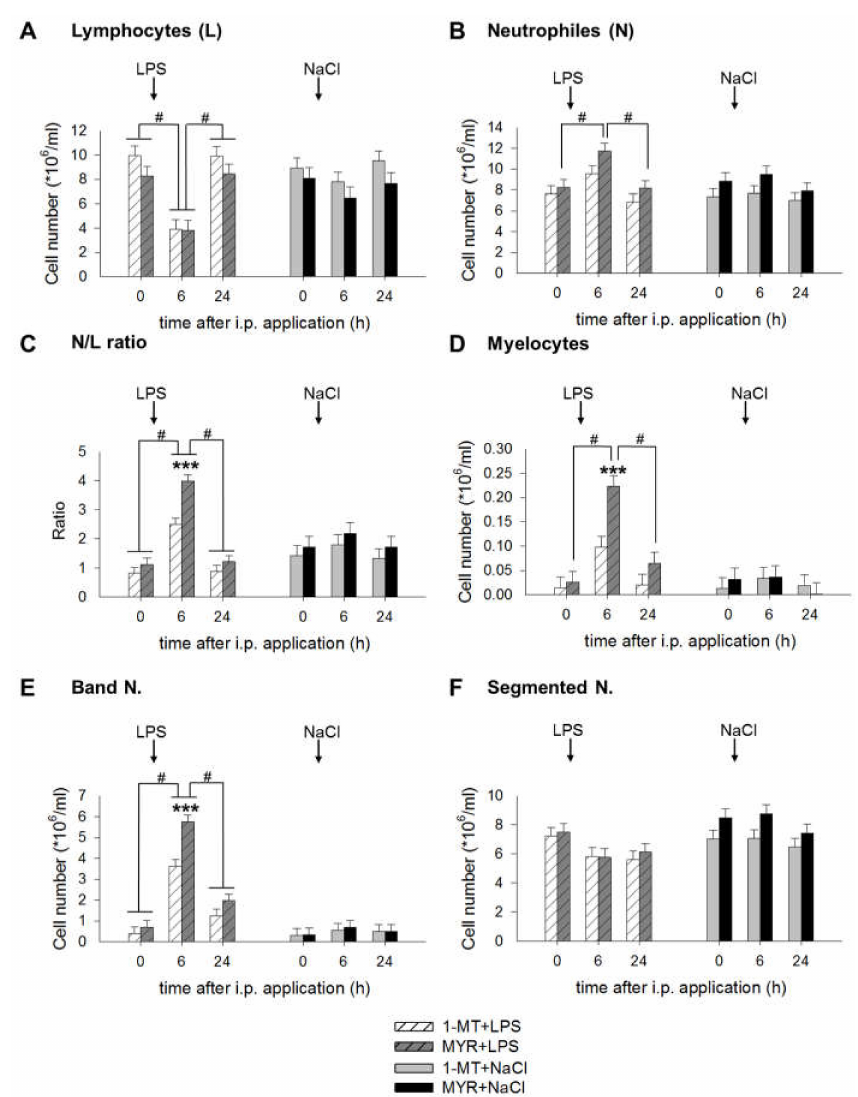
Figure 4. Effects of LPS on the number of lymphocytes ( A ), neutrophils ( B ), N/L ratio ( C ), myelocytes ( D ), band neutrophils ( E ) and segmented neutrophils ( F ) and its interference by 1-MT. Treatment with NaCl and pre-treatment with MYR were used as control groups. LPS or NaCl were injected i.p. directly after blood sampling at 0 h. The animals received the fifth s.c. 1-MT injection at 12 h after LPS/NaCl treatment to prevent a decline in 1-MT levels during the period of the LPS response. The cell number was measured by differential leukocyte counts using a total of 200 leukocytes per animal and time point. All data are presented as LS-means ± SE. Significant differences between 1-MT- and MYR-pre-treated groups were calculated using the Tukey–Kramer test and are indicated for each time point/period by asterisks. Significant differences between the time points are indicated by hashes within each treatment group. For time points 0 and 6 h: n = 11-12/group (total n = 47); for time point 24 h: n = 5-6/group (total n = 23); *** p < 0.001, # p < 0.01. The concentrations of TNF- α and IL-10, measured immediately before the LPS application (0 h), were not affected by 1-MT. Treatment with LPS induced a significant increase of plasma TNF- α